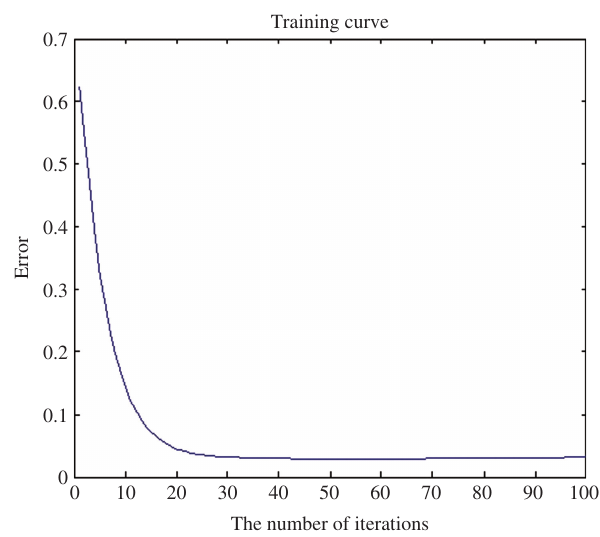
Figure 8. Training Curve of the BP Neural Network.